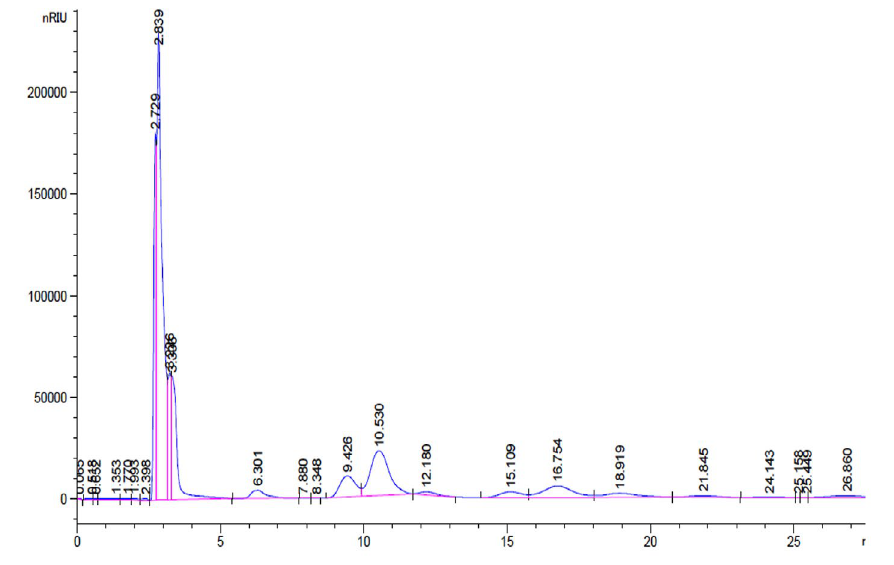
Fig. 5. Standard GOS peaks with retention factor- Galactose and Glucose 2.63, Lactose 6.36, disaccharides 10.53 and 12.18, trisaccharides 16.75, 18.91 and tetrasaccharides 21.8 and